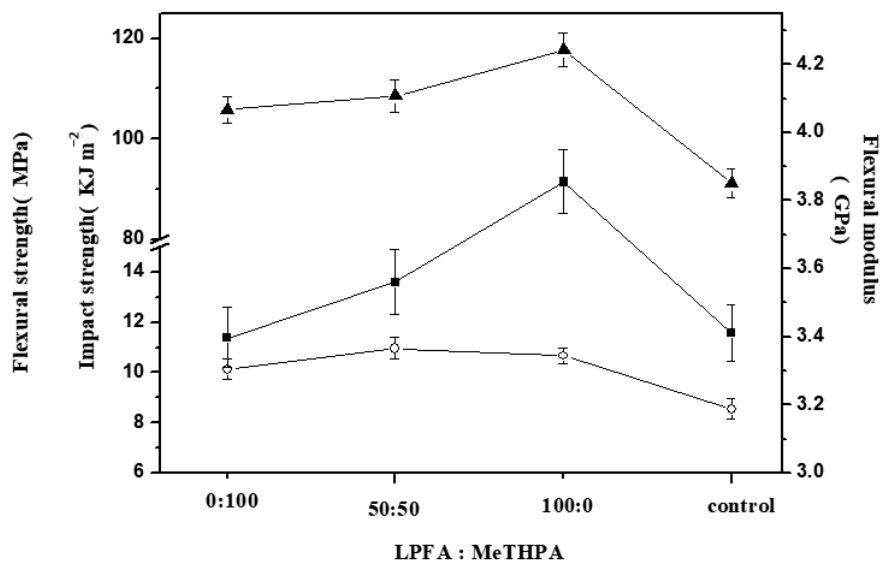
Figure 7. Dependence of impact strength ( ○ ), flexural strength ( ▲ ) and flexural modulus ( ■ ) of the cured epoxy resins on different anhydrides.